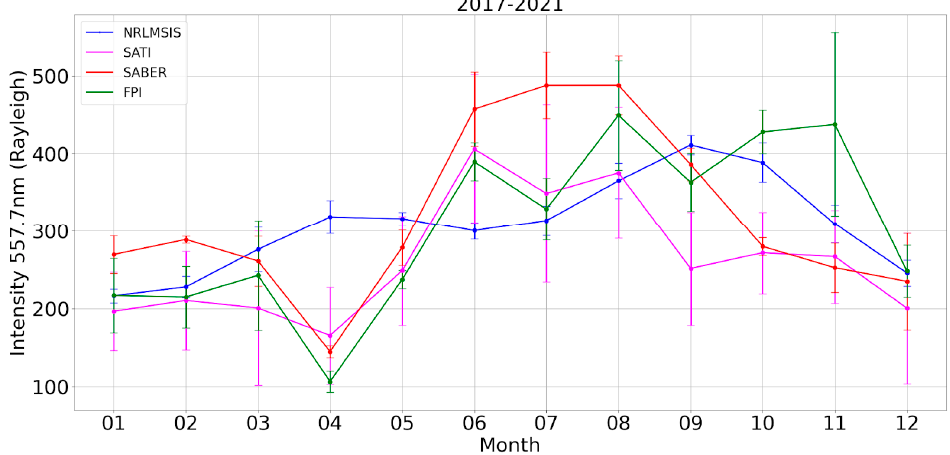
Figure 7. Monthly average I 557.7 nm from 2017 to 2021 from SABER (red), FPI (green), NRLMSIS model (blue) and SATI (violet) data and their deviations.